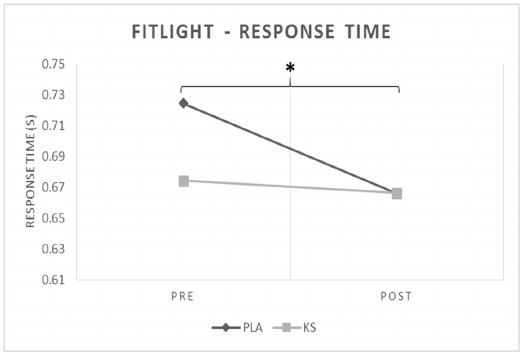
Figure 5. Mean slowest response time during eyes open dual-task postural stability test, before (PRE) and after (POST) the treadmill workload in firefighters. Groups: Placebo (PLA) and Ketone (KS). * represents significant difference for PLA from KS during POST at p <